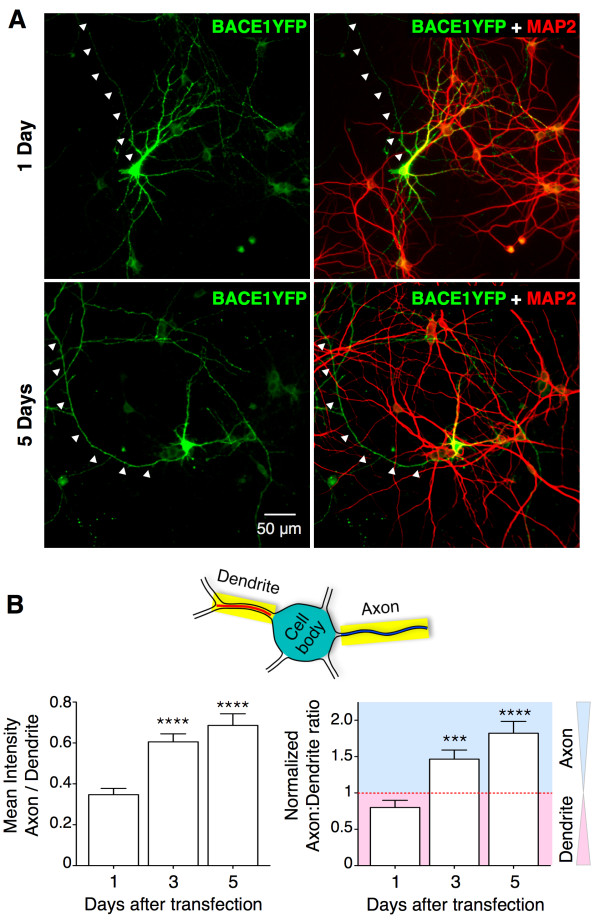
Preferential axonal targeting of BACE1-YFP over time after transfection in cultured hippocampal neurons. (A) Cultured hippocampal neurons were co-transfected with plasmids expressing BACE1-YFP and Cerulean on DIV5 (when they have already developed dendrites and long axons) and polarized distribution of BACE1-YFP was analyzed after 1, 3, and 5 days of transgene expression. Representative images of BACE1-YFP distribution neurons 1 or 5 days after transfection are shown. MAP2 staining was used to identify dendrites and, by exclusion, axons (arrowheads). (B) Mean axon-to-dendrite fluorescence intensity ratios were calculated for BACE1-YFP and Cerulean along major axon and dendrite segments in co-transfected neurons analyzed after 1, 3, and 5 days of transgene expression (n = 23-28 neurons each imaged from four coverslips per time point, two independent cultures).